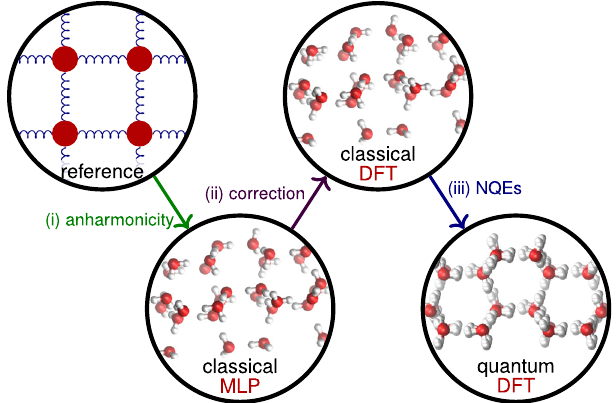
Fig. 1 Schematic illustration of the procedure. Thermodynamic integration steps from a reference system to the classical system described by the MLP, to the classical system described by DFT, and fi nally to the system with quantum-mechanical nuclei described by